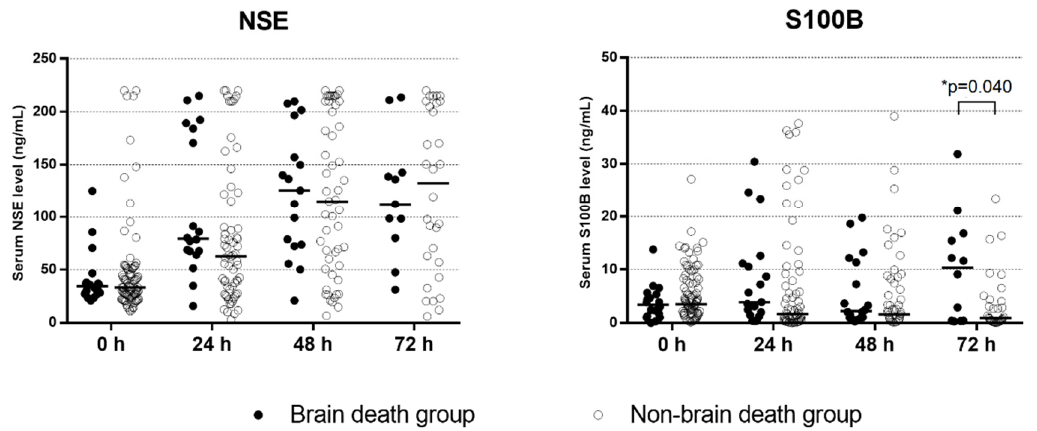
Figure 4. Serial serum NSE and S100B levels in the brain death group and the non-brain death group. Bars represent medians. * p = 0.040 using the Mann–Whitney U test. NSE, neuron-specific enolase; S100B, S100 calcium-binding protein B.